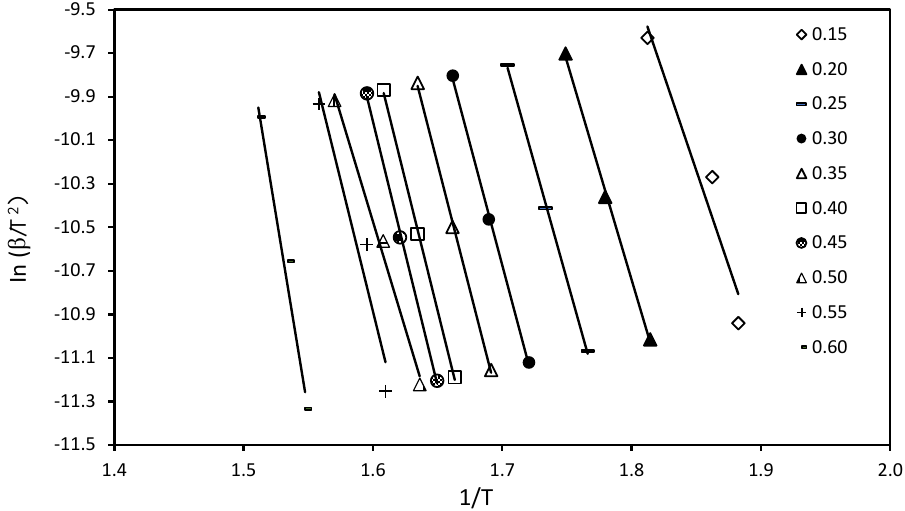
Fig. 4. Plots for determination of the kinetic parameters of MSH using